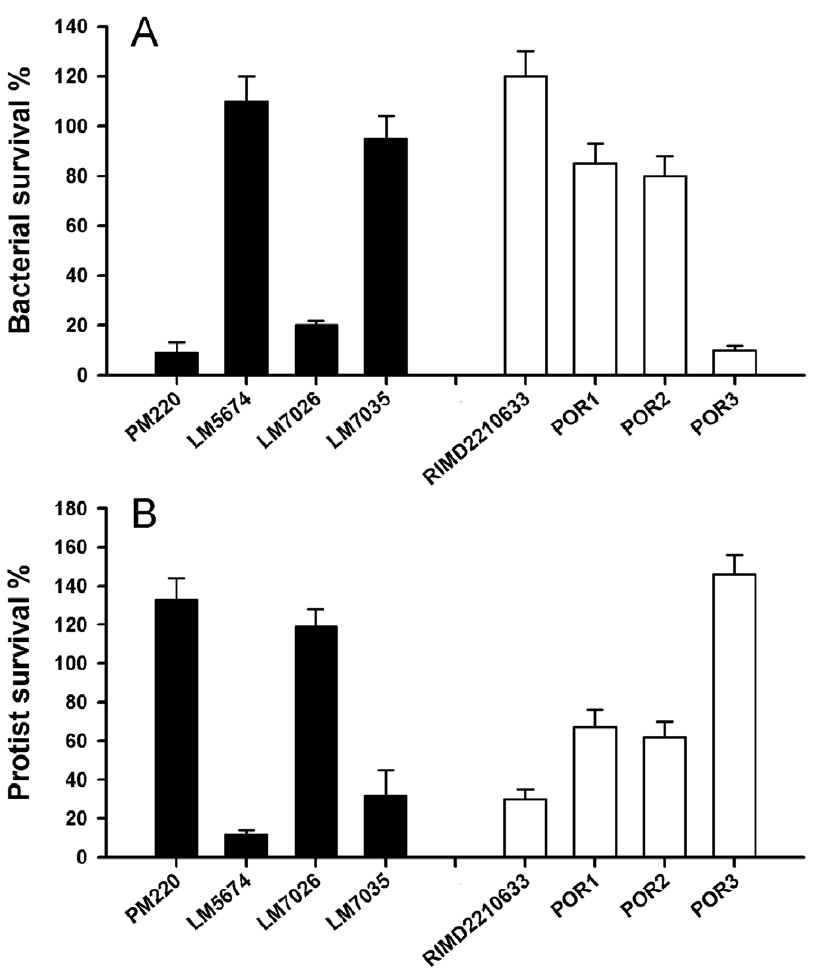
Figure 1. Accessory type III secretion system promotes survival of V.parahaemolyticus . Cell suspensions of environmental (filled bars) and clinical strains (open bars) of V. parahaemolyticus were co-cultured with the marine flagellate C. roenbergensis . Bacterial (A) and flagellate (B) survival are given as relative change of initial cell numbers after 24 h of co-incubation of C. roenbergensis with V. parahaemolyticus strains: the environmental isolates PM220 ( tdh 2 /T3SS-2 2 ) and LM5674 ( tdh + /T3SS-2 + ) versus mutants defective in T3SS-2 (LM7026) and T3SS-1 (LM7035); and the clinical isolate RIMD2210633 ( tdh + /T3SS-2 + ) versus mutants defective in TDH (POR1), T3SS-1 (POR2) and T3SS-2 (POR3). Error bars represent standard deviations